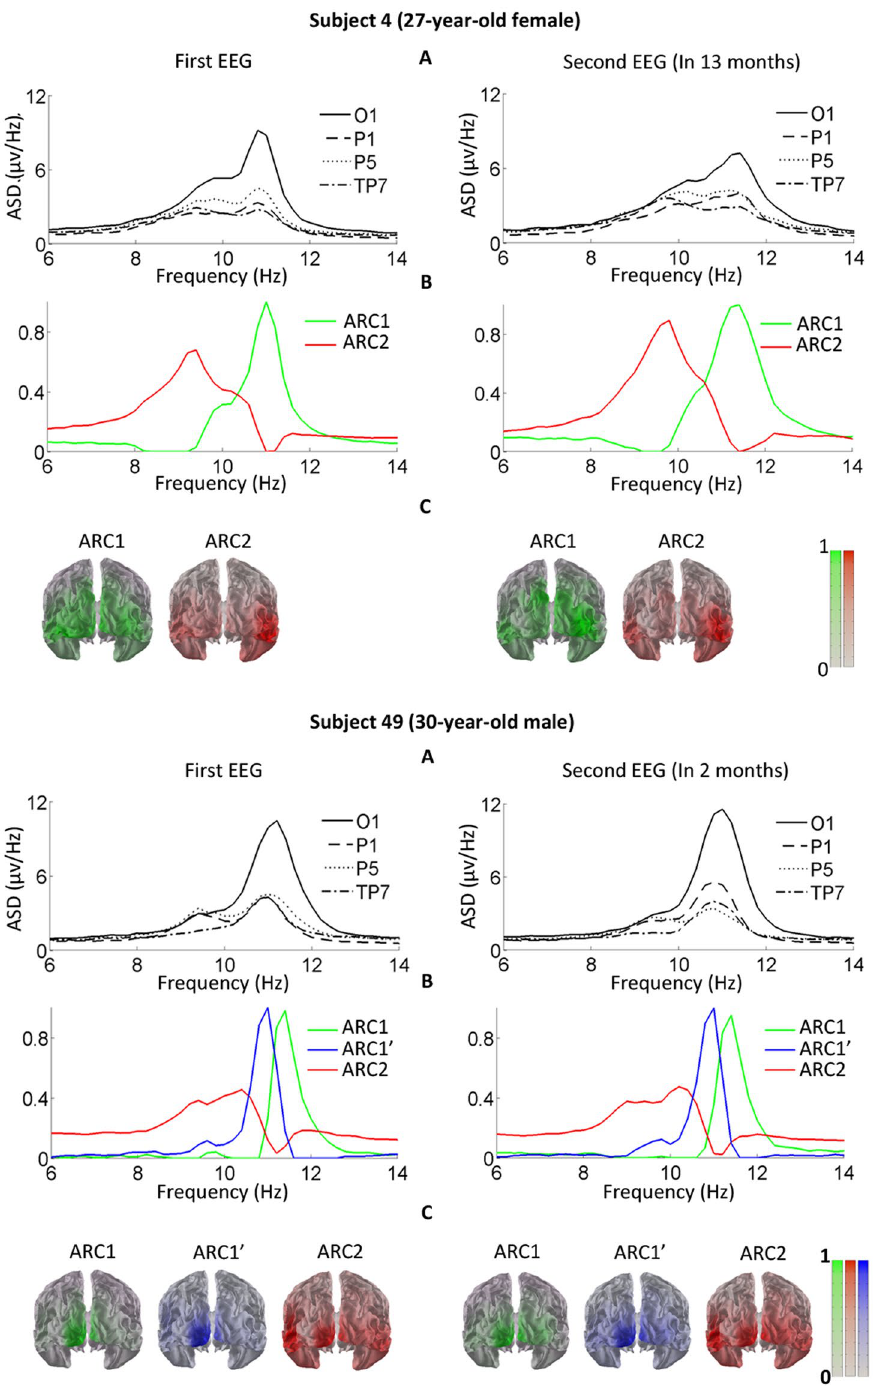
Figure 4. Follow-up illustrates individually stable multi-component structure of alpha rhythm. The representative examples show the component structure of the alpha rhythm in subject 4 with two ARCs and subject 49 with three ARCs, based on two EEG recordings separated by several months. All designations are as in Fig.